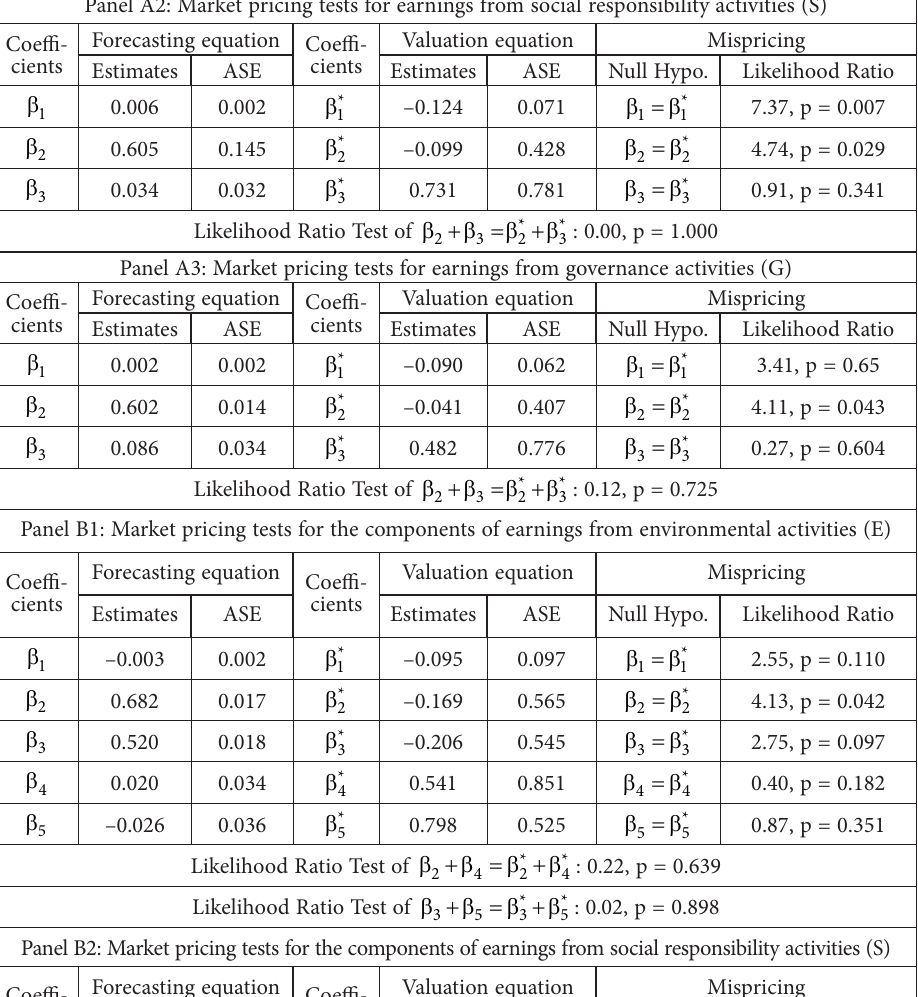
Panel A2: Market pricing tests for earnings from social responsibility activities (S)